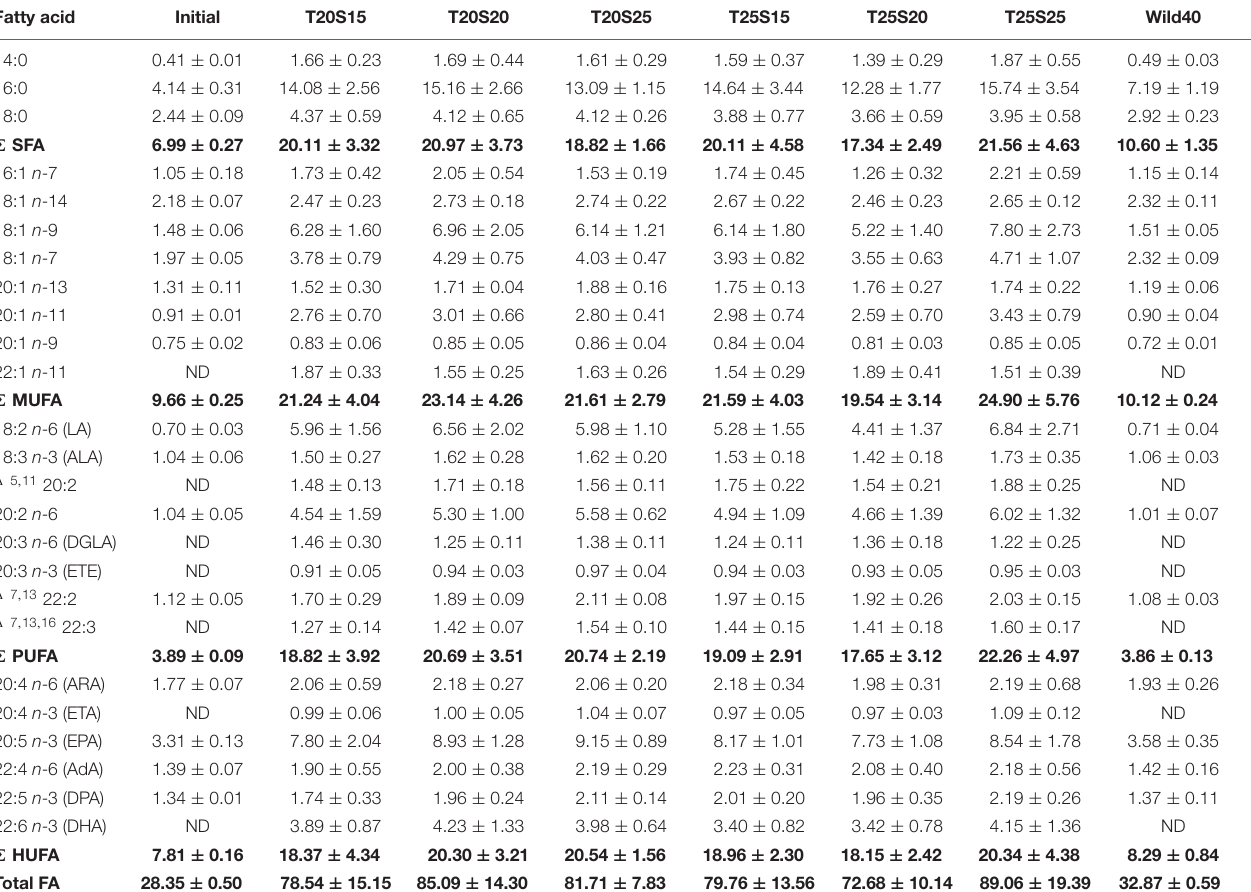
TABLE 3 | Fatty acid profile ( µ g mg − 1 DW) of Hediste diversicolor fed during 40 days with a commercial aquafeed under different combinations of temperature (T—20 and 25 ◦ C) and salinity (S—15, 20, and 25), along with conspecifics initially stocked (Initial) and conspecifics collected from the wild at the same time point (Wild40). Fatty acid Initial